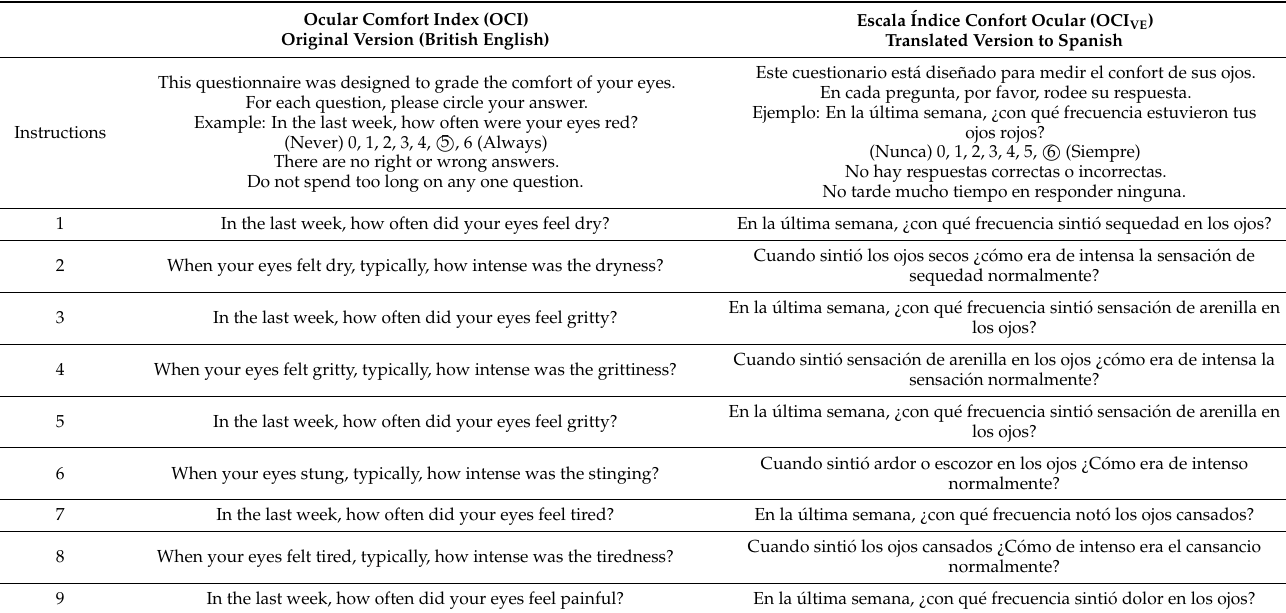
Table 1. Items, instructions, and response options of the original OCI and Spanish version (OCI VE ). Ocular Comfort Index (OCI) Original Version (British